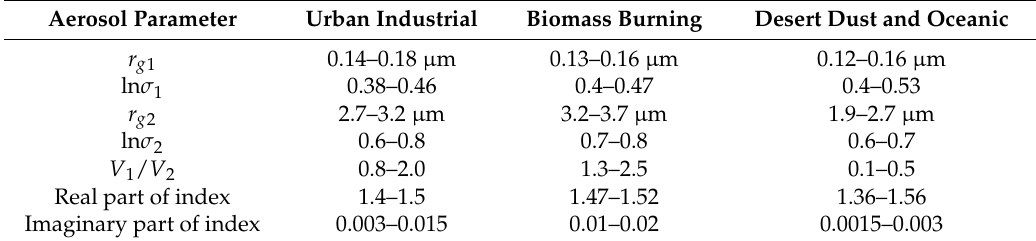
Table 2. Typical parameters of different biomodal lognormal aerosol types a